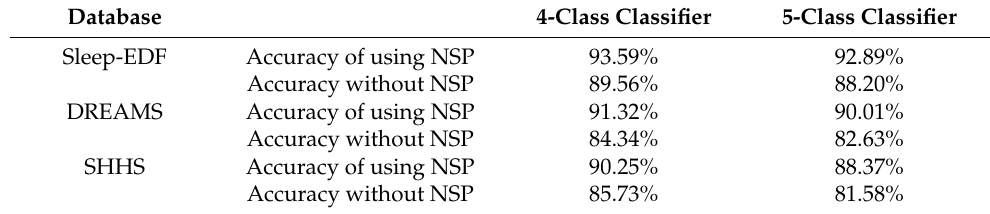
Table 8. Classification accuracy using or not NSP